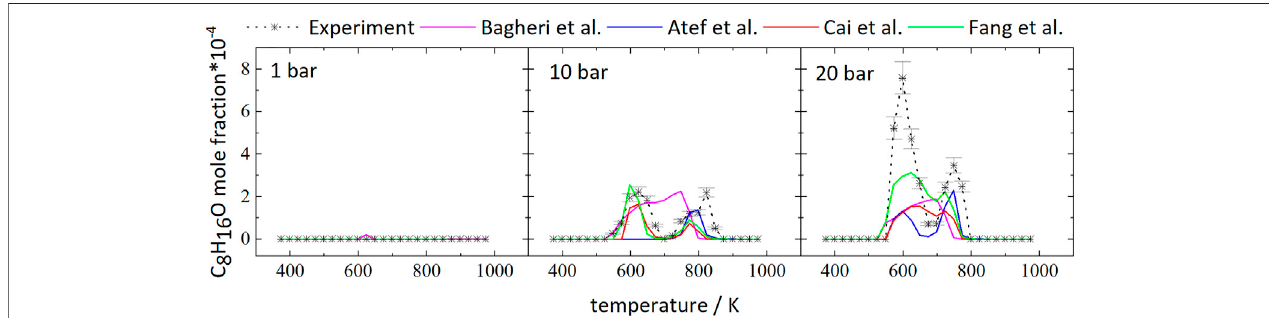
FIGURE 12 | Mole fractions of 2,2,4,4-tetramethyl-tetrahydrofuran vs. reactor-temperature at 1, 10, and 20 bar. Dashed lines with symbols and solid lines illustrates the experimental and modeled results, respectively.